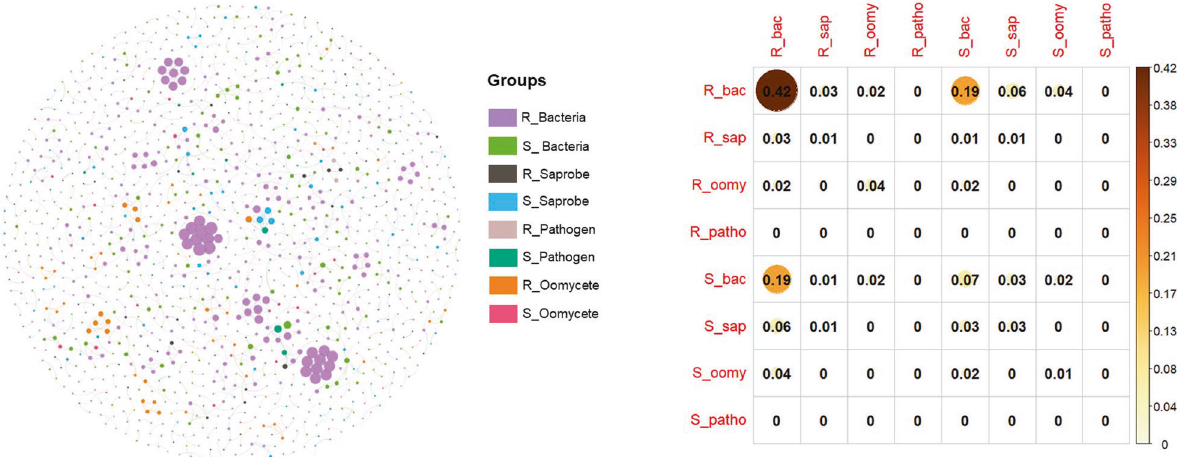
Fig. 2 Networks analysis revealing the co-occurrence patterns between microbial groups. The nodes were colored according to group labels. A connection represents a strong (Spearman ’ s correlation coef fi cient r > 0.8) and signi fi cant ( p < 0.001) correlation. The size of each node is proportional to the number of connections. “ R ” , “ S ” represent root and soil samples,